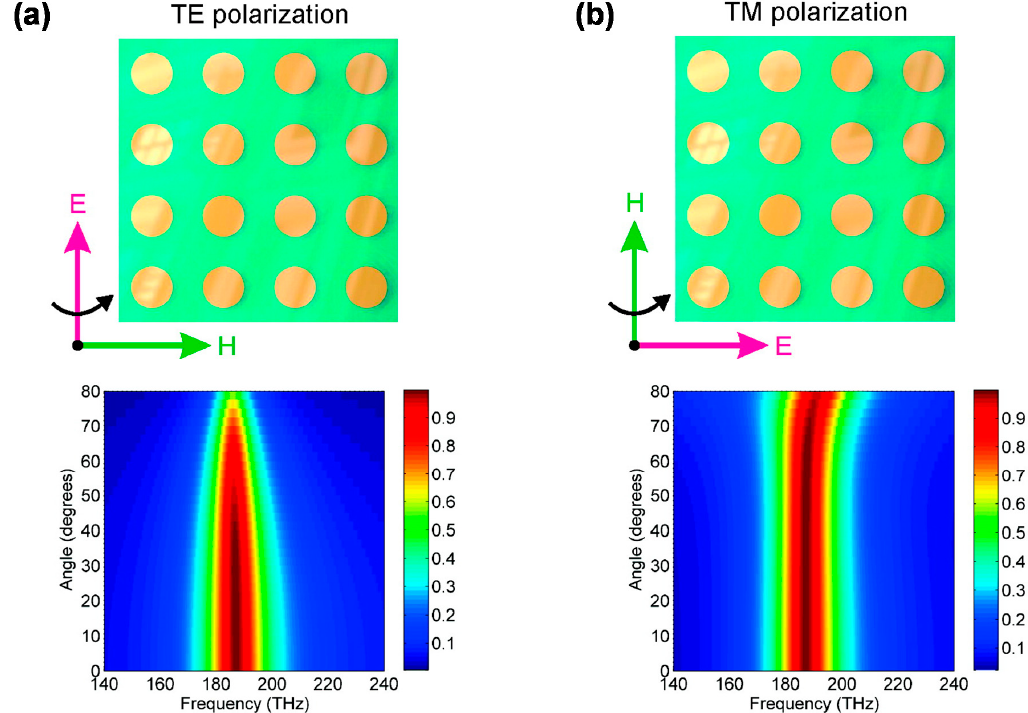
Figure 5. Calculated absorption for the ( a ) transverse-electric (TE) and ( b ) transverse-magnetic (TM) modes. Figures are adapted with permission from Reference [22]. © 2010 American Chemical Society.